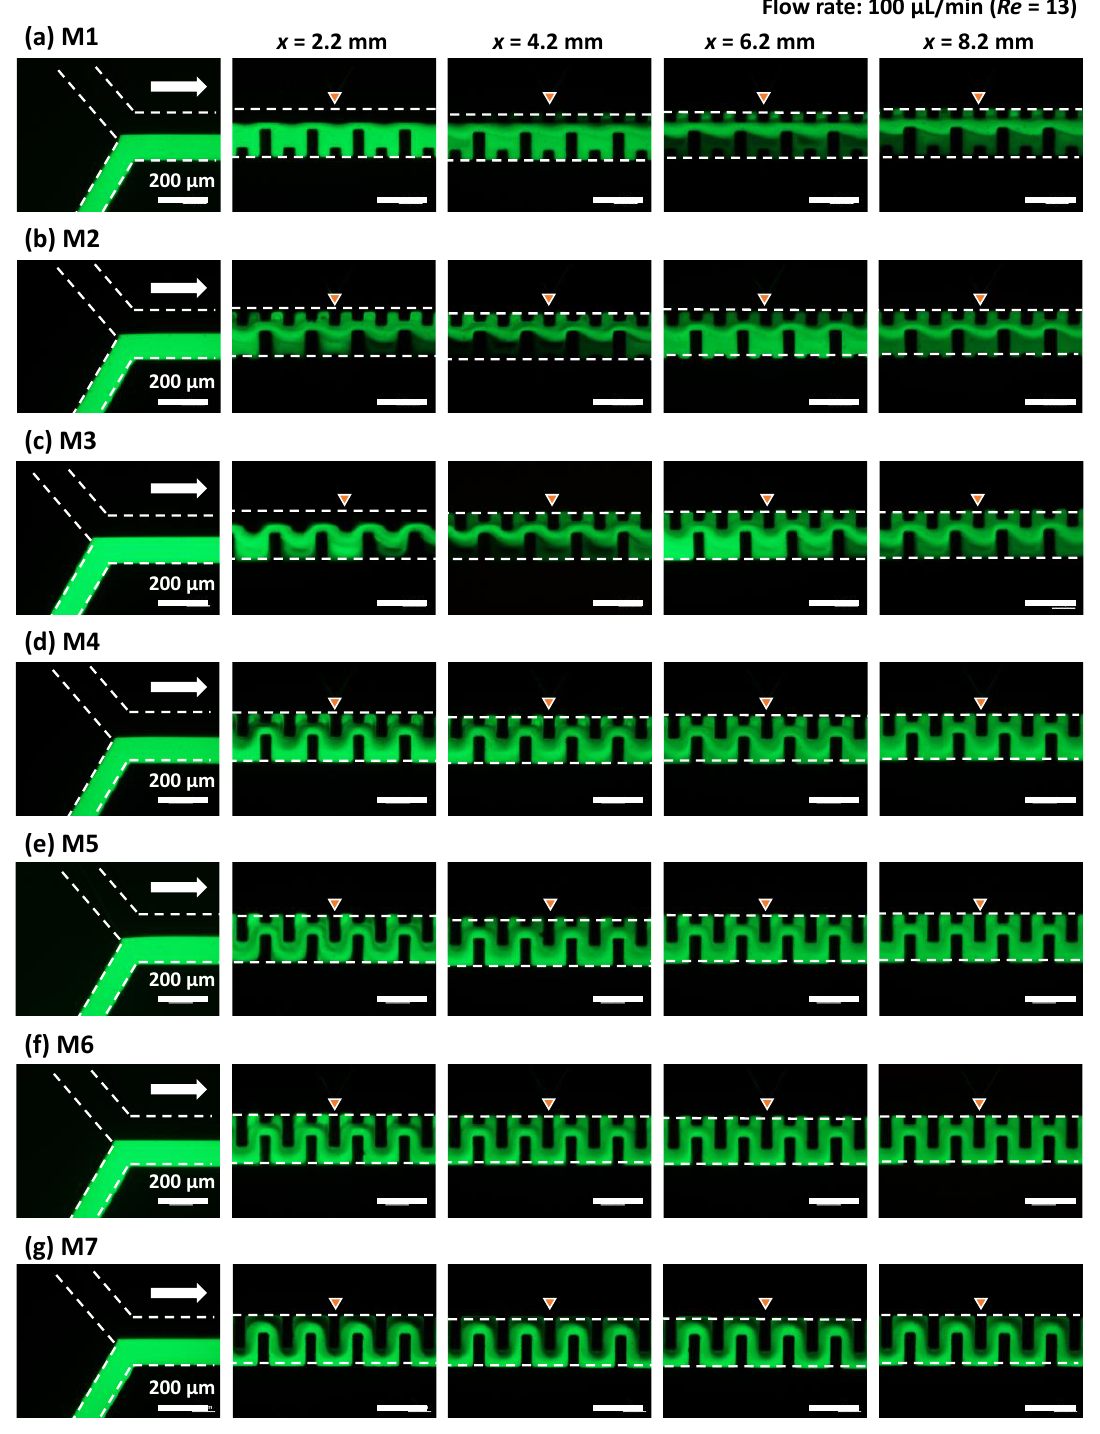
Figure 9. Experimental investigation of the mixing behaviors of ( a – f ) six different types of asymmetric micromixers (M1–M6) and ( g ) the serpentine micromixer (M7) with a perfectly symmetric mixing unit. Pure water and fluorescein-dyed water (0.1 mol/m 3 ) were introduced at the same flow rate of 50 µL/min (a total flow rate of 100 µL/min and Re = 13).